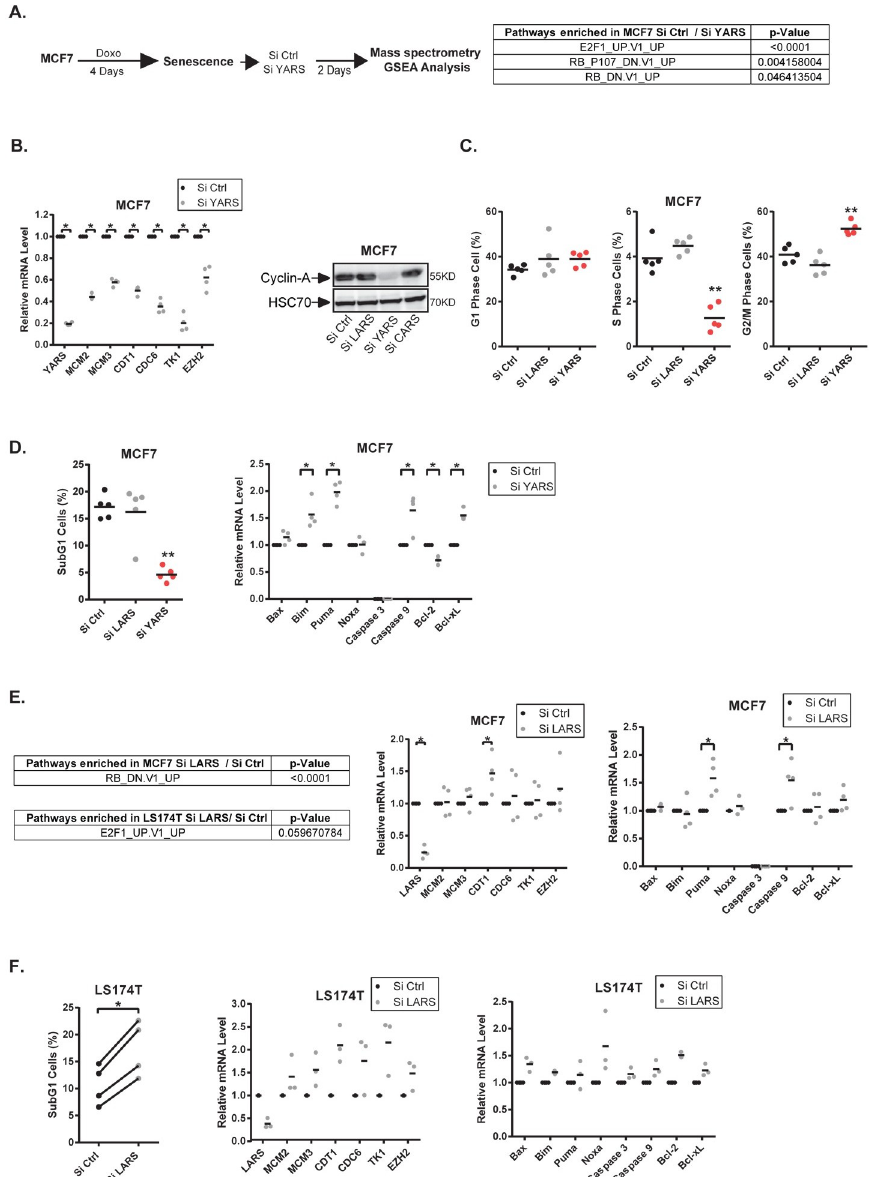
Fig 7. YARS and LARS regulate E2F targets during CIS escape. A. Senescent cells were transfected with a control siRNA or a siRNA directed against YARS. Cell extracts were analyzed by SWATH quantitative proteomics and GSEA analysis 2 days after depletion (n = 3). B. Analysis by RT-QPCR and western blot of E2F1 proliferative targets in MCF7 cells following YARS depletion (n = 4, Kolmogorov-Smirnov test, � = p < 0.05, n = 2 for western blot). C. Senescent cells were transfected with a control siRNA or a siRNA directed against YARS or LARS. After two days, FACS analysis was performed to analyze the cell cycle profile of the indicated cells (n = 5, Kolmogorov-Smirnov test, �� = p < 0.01). D. Senescent MCF7 cells were transfected as above, FACS analysis was performed to analyze apoptotic cells (n = 5, Kolmogorov-Smirnov test, �� = p < 0.01). The expression of the indicated mRNAs was analyzed in parallel by RT-QPCR (n = 4, Kolmogorov-Smirnov test, � = p < 0.05). E. MCF7 or LS174T senescent cells were transfected with a control siRNA or a siRNA directed against LARS. Cell extracts were analyzed by SWATH quantitative proteomics and GSEA analysis 2 days after depletion (n = 3). In parallel, the indicated mRNAs were analyzed by RT-QPCR in MCF7 cells following LARS depletion (n = 4, Kolmogorov-Smirnov test, � = p < 0.05). F. LS174T senescent cells were transfected as above, FACS analysis was performed to analyze apoptotic cells (n = 4). The expression of the indicated mRNAs was analyzed in parallel by RT-QPCR (n = 3).